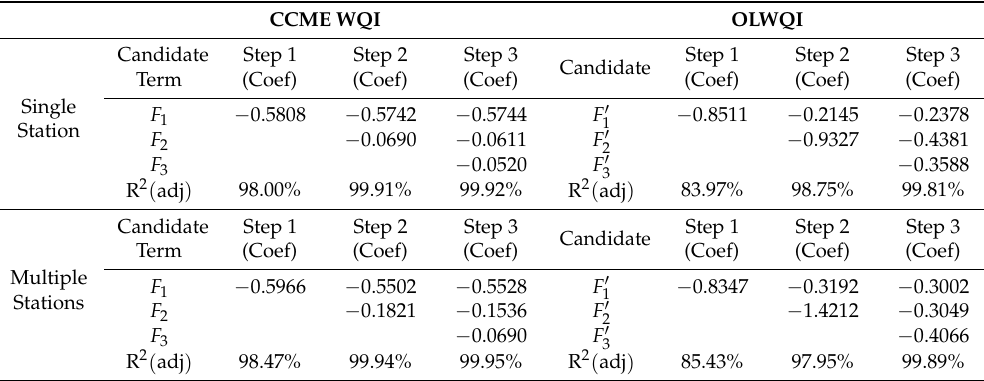
Table 6. Stepwise Regression Analysis: Final Index versus Three Factors.